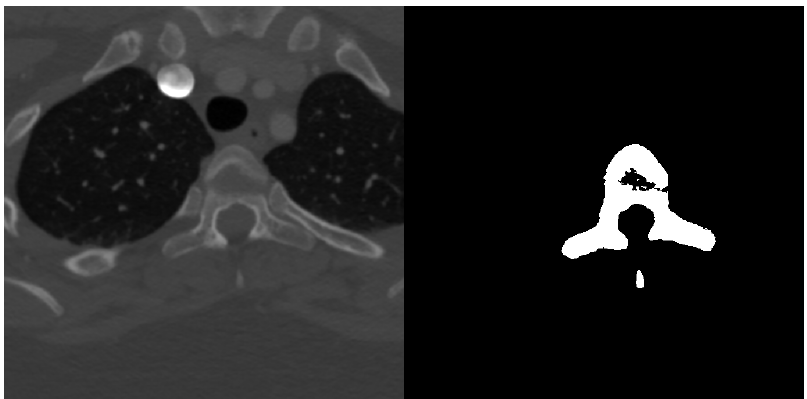
Figure 3. Example transversal image slice from spine dataset ( left ) with according ground truth mask ( right ).